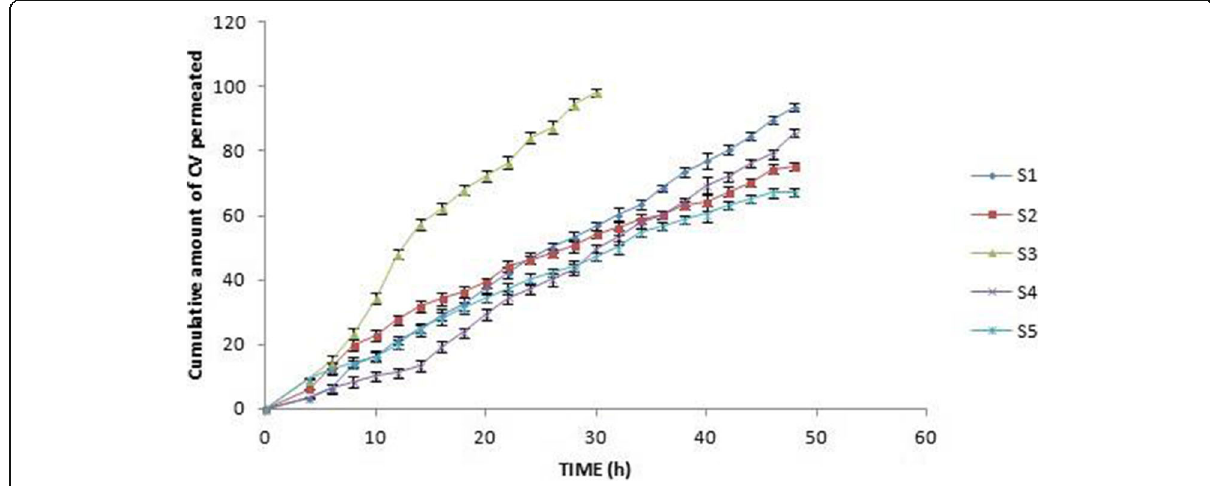
Fig. 1 Comparison of in vitro permeation profiles of CV across excised rat skin from patches with S1 – S5 (mean ± SD, n = 3)